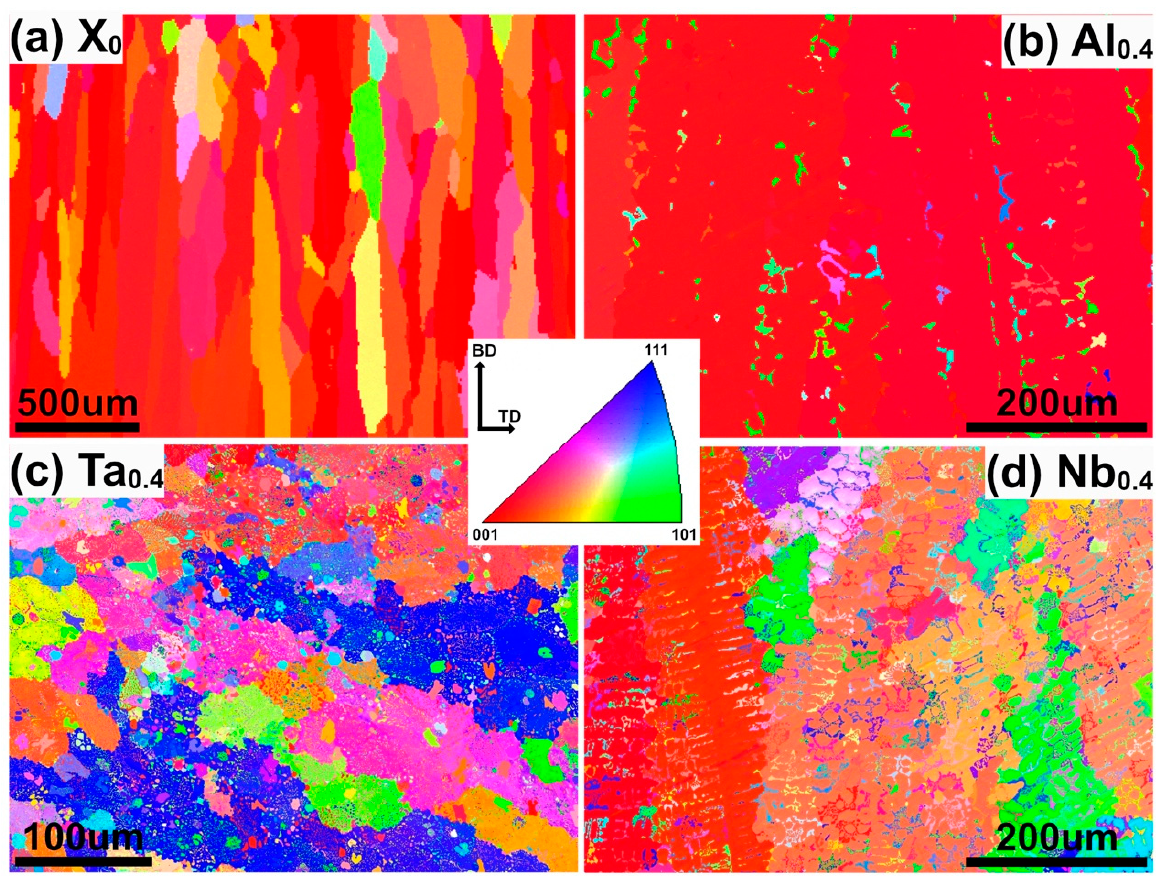
Figure 2. IPF of ( a ) CoCrFeNi, ( b ) CoCrFeNiAl 0.4 , ( c ) CoCrFeNiTa 0.4 , and ( d ) CoCrFeNiNb 0.4 HEAs, prepared by PPA-AM. The compression stress–strain curves are shown in Figure 3. The CoCrFeNi alloy has the lowest yield strength, and the Al addition slightly increases the strength of CoCrFeNi in the compression test. Both have no brittle fracture due to good plasticity (note that the tests were stopped at 0.6 strain). Comparatively, for a particular strain value, the Ta and Nb alloys exhibit a high yield and fracture strengths. Among them, the fracture strength of the Ta 0.4 alloy is better than the traditional vacuum arc melting process [16,17,29]. Since the Ta 0.4 and Nb 0.4 alloys have the same precipitation phase [14,16,23], the difference in strength may be related to the formation of a fine eutectic structure in the Ta 0.4 alloy.